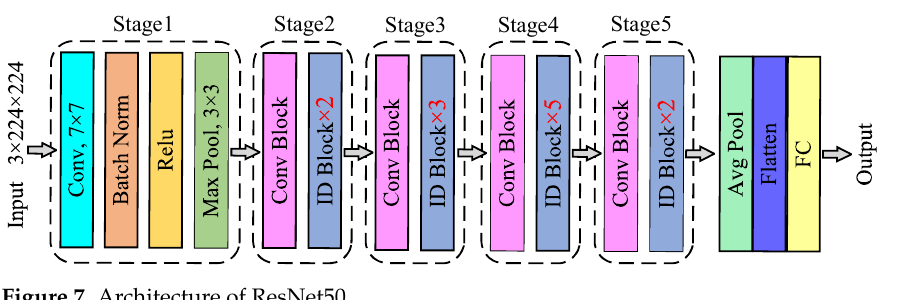
Figure 7. Architecture of